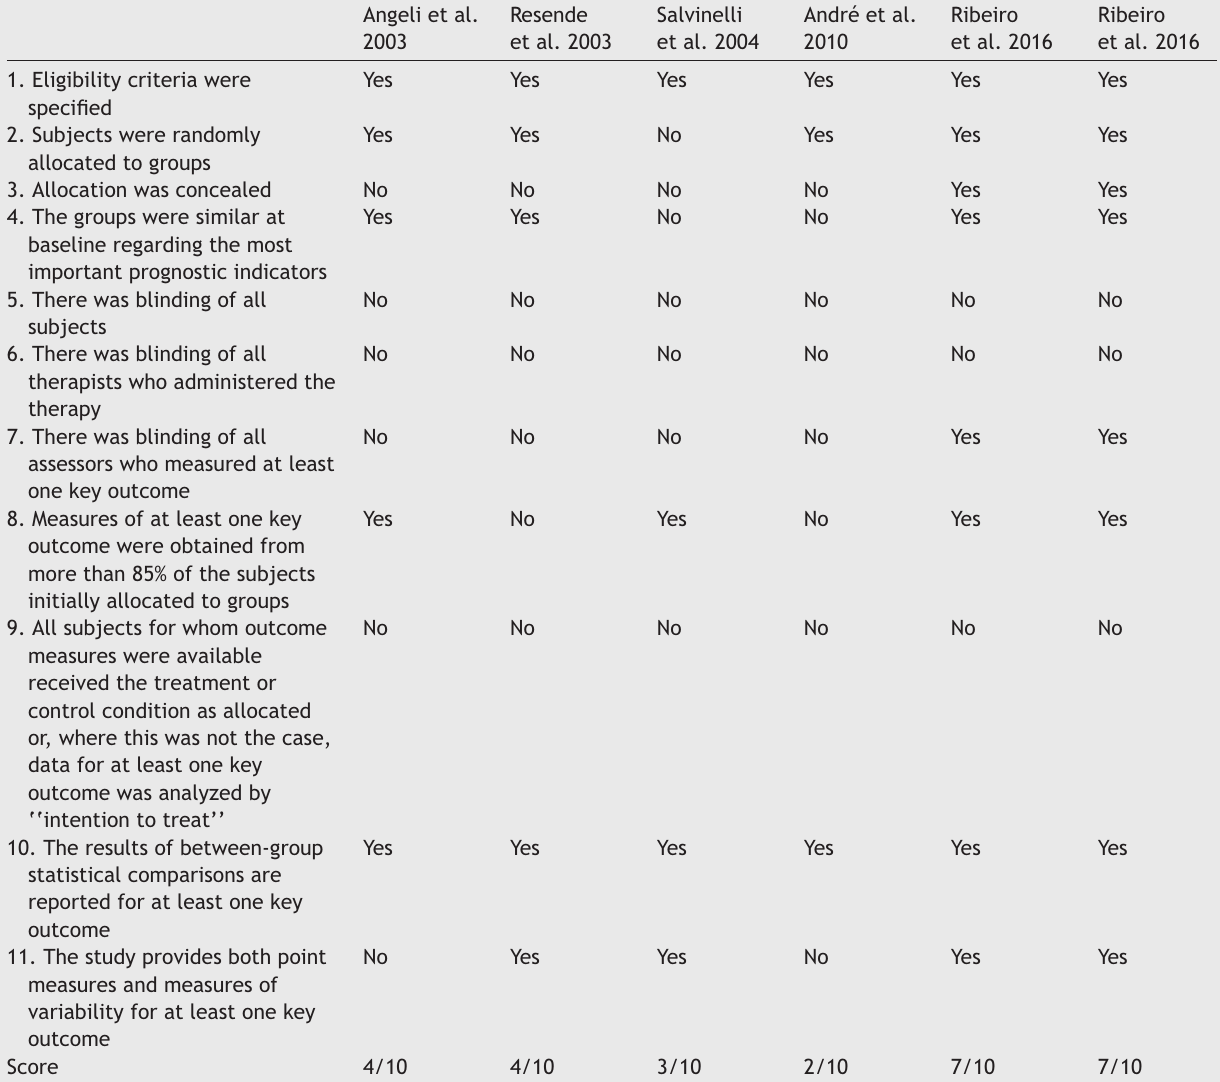
Table 2 Methodological analysis by PEDro score of clinical trials about the effectiveness of Otolith Repositioning Maneuvers (ORM) and Vestibular Rehabilitation (VR) exercises in the treatement of Benign Paroxysmal Positional Vertigo (BPPV) in elderly